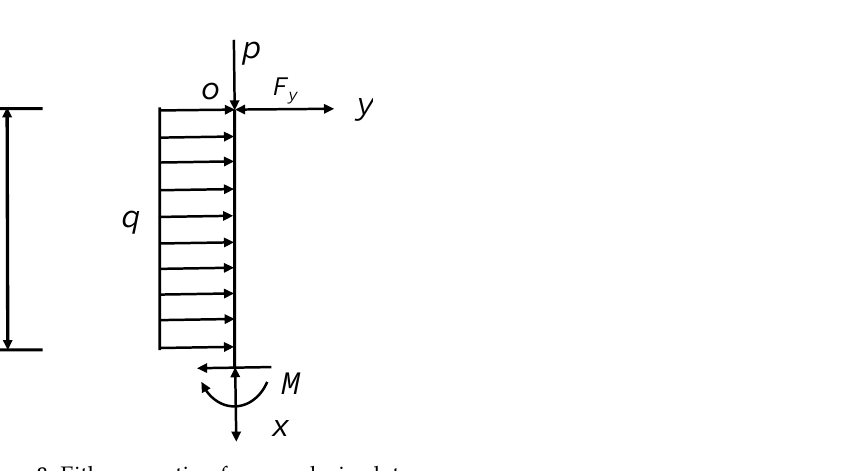
Figure 8. Either x-section force analysis plot.